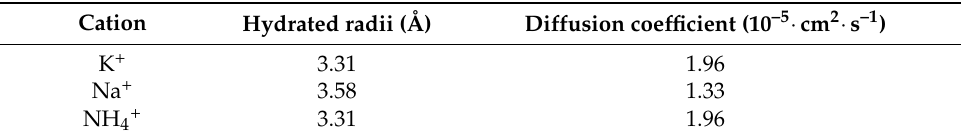
Table 1. Comparison of hydrated radii and diffusion coefficient (in water) of main metal ions present in urine [12,13].